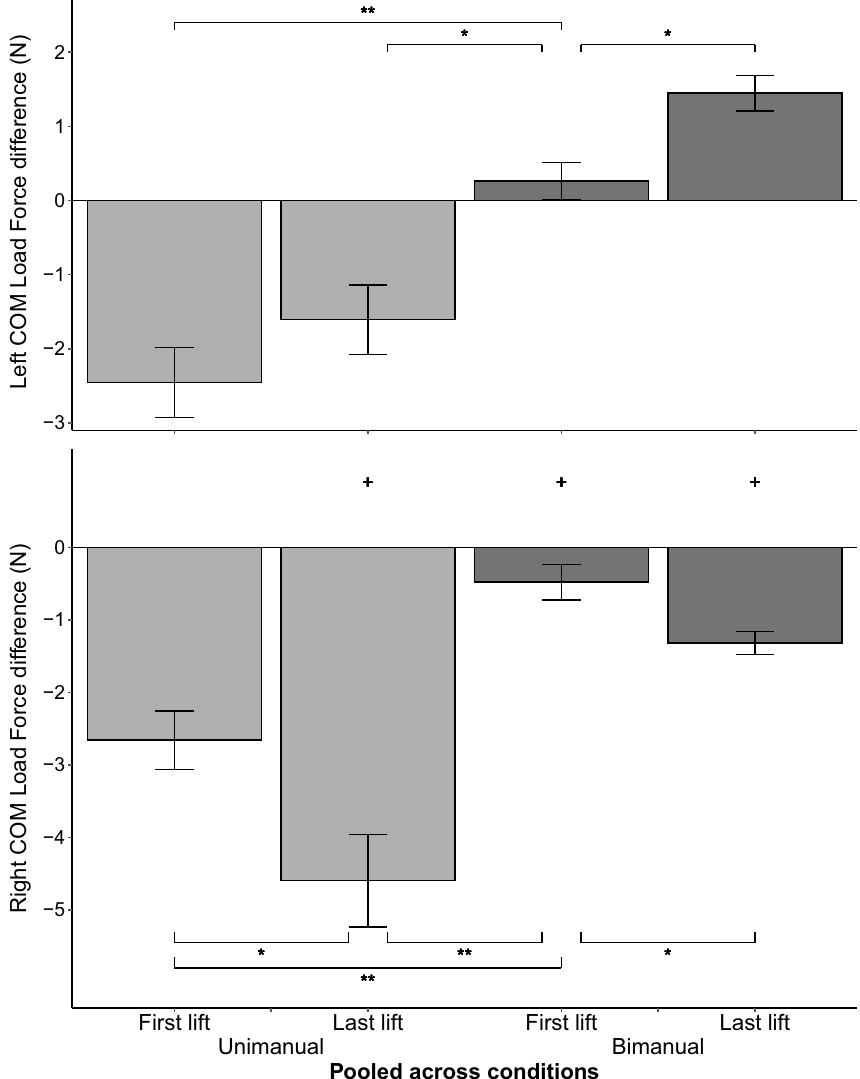
Figure 6. Results for Load Force difference (LF diff ). Average LF diff for the left COM (top panel) and right COM (bottom panel) for the first and last lifts in each grasp type (± s.e.m). Results were pooled across conditions after no significant effect was found between conditions. Light grey bar indicates LF diff for the right-hand unimanual trials. Dark grey bar indicates LF diff for the bimanual trials. Error bars indicate the standard error of the mean. * p < .05, ** p < .001, + p < .05 between the left and right